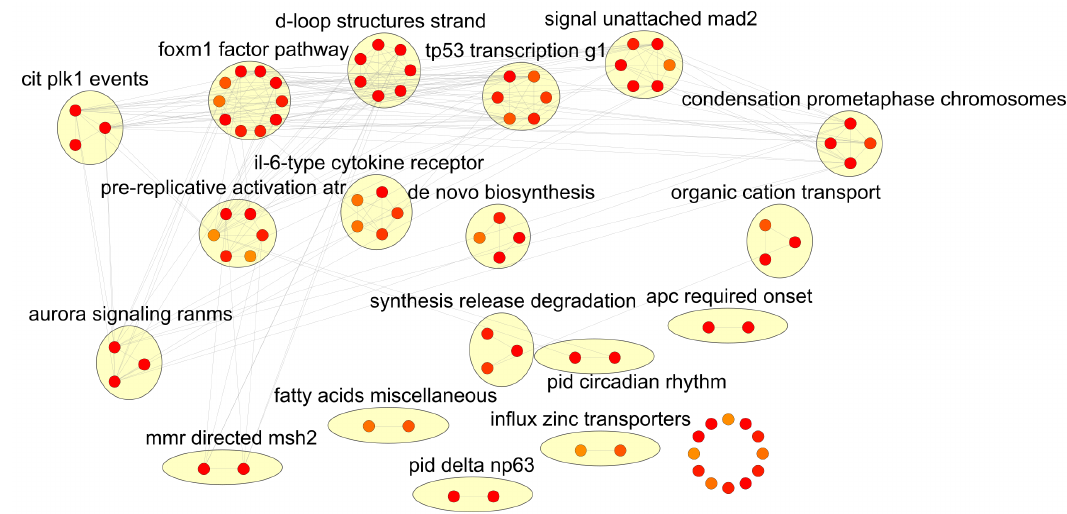
Figure 5. Enrichment map shows consistently high-scoring pathway features when running the breast tumour binary classifier with real-world parameters. This network is generated by running the plotEmap() function, which uses the RCy3 Bioconductor package to programmatically call Cytoscape network visualization software from within R, to run the EnrichmentMap app 5–7 . Nodes show pathways features that scored a minimum of 9 out of 10 in feature selection, in at least 70% of train/test splits; node fill indicates feature score. Edges connect pathways with shared genes. The larger yellow bubbles are auto-generated by the AutoAnnotate Cytoscape app 6,8 ; these thematically group top pathways, by clustering and word-frequency based cluster annotation.